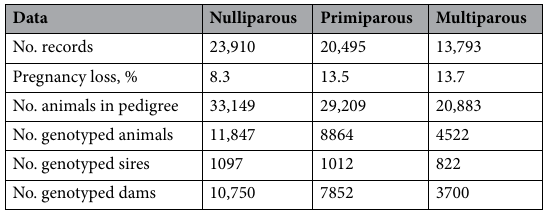
Table 1. Summary of data by